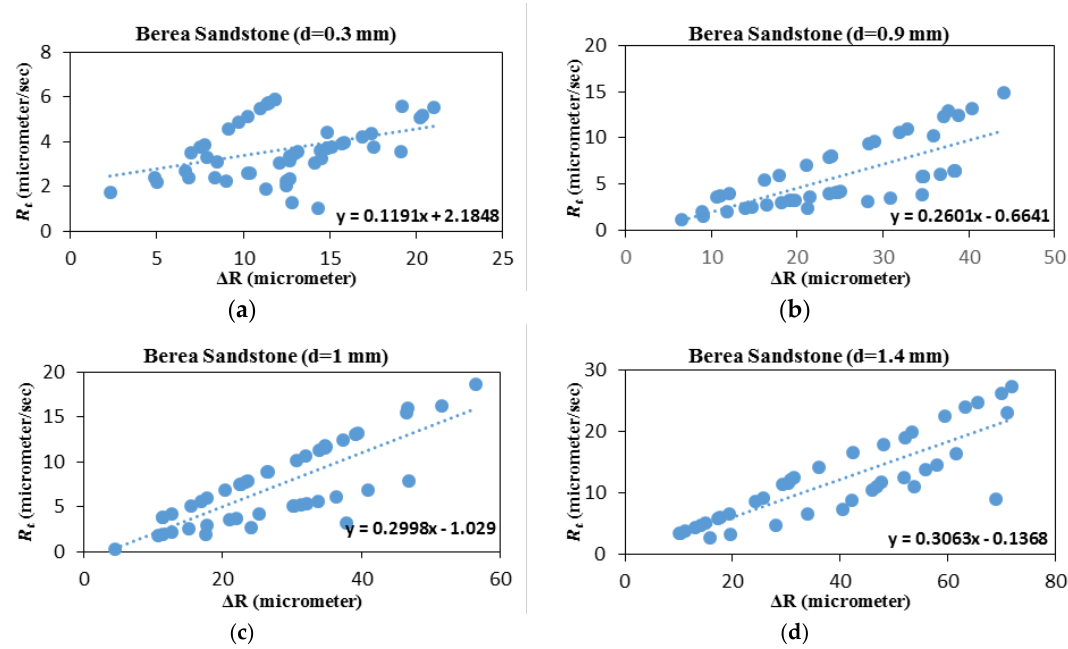
Figure 14. Variation of instant roughness change versus roughness change at DOCs: ( a ) d = 0.3 mm; ( b ) d = 0.9 mm; ( c ) d = 1 mm; ( d ) d = 1.4 mm. ( b ) d = 0.9 mm; ( c ) d = 1 mm; ( d ) d = 1.4 mm.